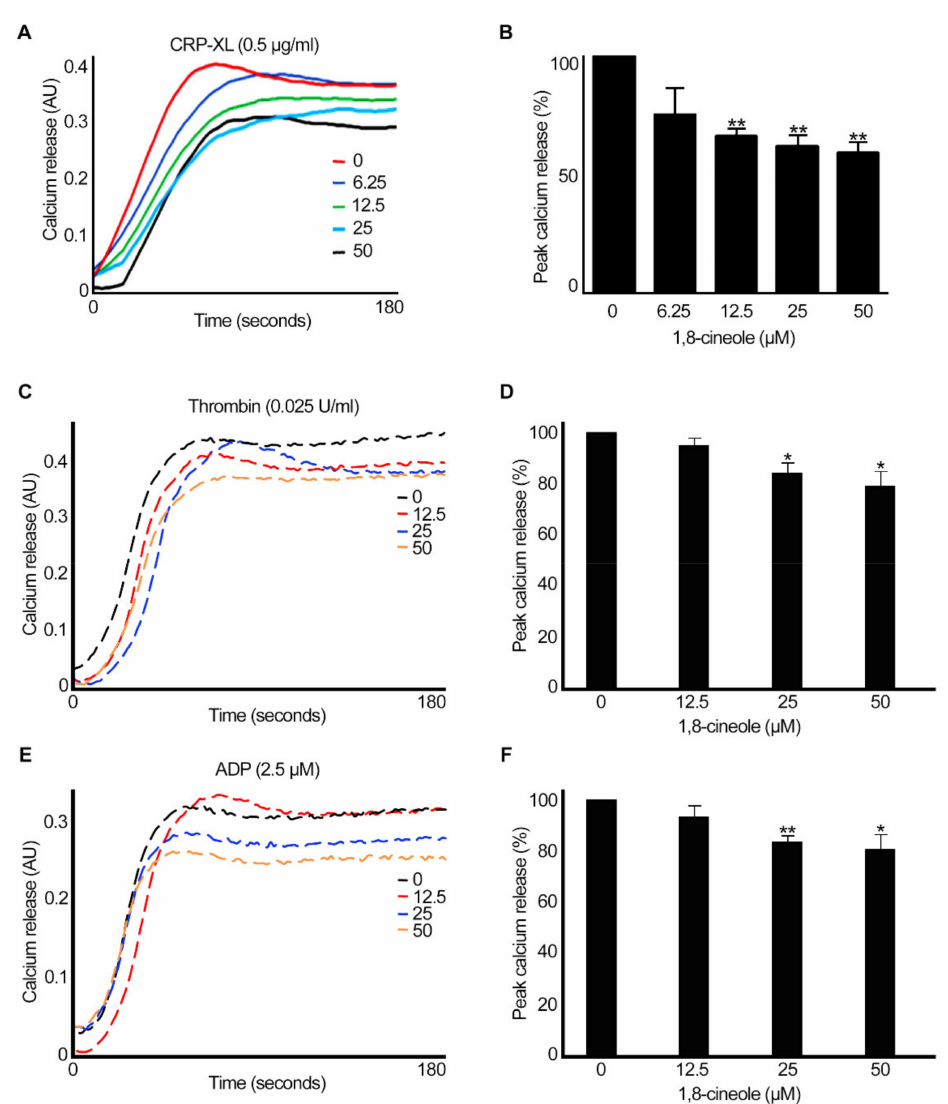
Figure 6. Effect of 1,8-cineole on intracellular calcium mobilisation in human platelets. Human PRP ( A , E ) or isolated platelets ( C ) treated with Fluo-4 AM dye were incubated with a vehicle control or various concentrations of 1,8-cineole for 5 min prior to stimulation of calcium release with CRP-XL (0.5 µ g/mL) ( A , B ), thrombin (0.025 U/mL) ( C , D ) or ADP (2.5 µ M) ( E , F ). The level of calcium release was monitored for 3 min by spectrofluorimetry. The traces shown are representative of four